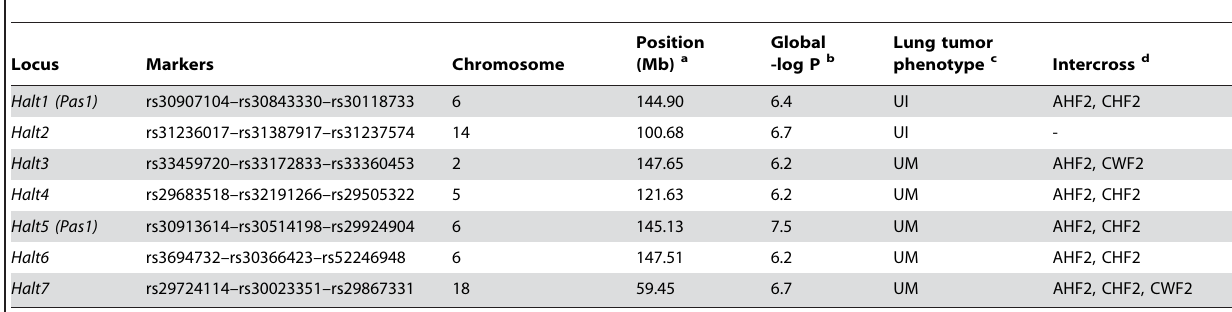
Table 4. Haplotype-associated lung tumor modifier ( Halt ) loci identified by haplotype analysis, using the 140K BROAD SNP panel.